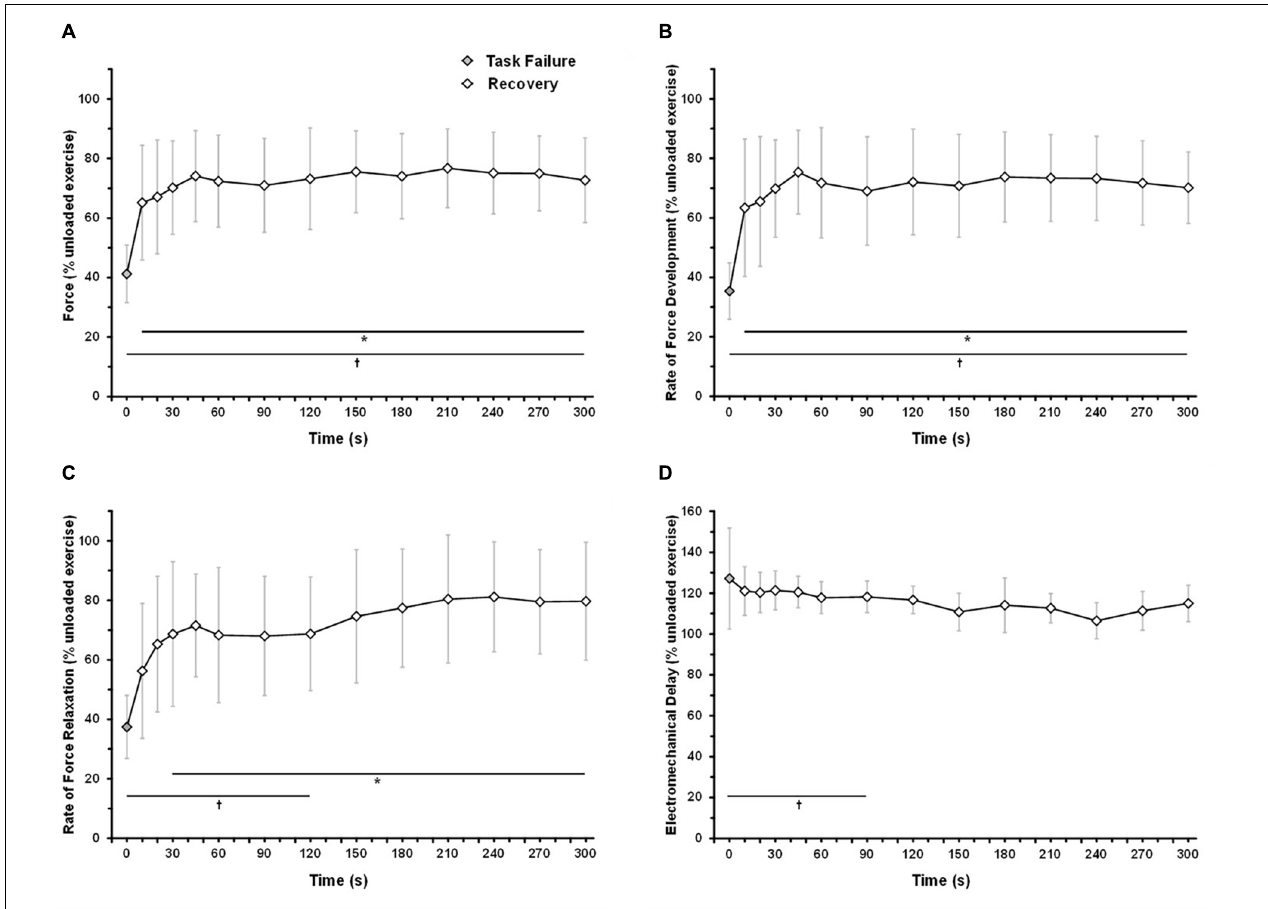
FIGURE 4 | Time-course of force and intratwitch indices recovery following an exhaustive 6-min exercise. The subjects performed one-legged knee-extension exercise at 6MP until exhaustion. At task failure, the load was removed, and the subjects were instructed to maintain the kicking frequency at 60 rpm (unloaded exercise). Force response from VL was elicited by an electrical stimulation (double twitch, 10-ms interval) 10, 20, 30, 45, and 60 s after task failure and subsequently every 30 s until 5-min recovery. (A) Force response, (B) rate of force development, (C) rate of force relaxation, (D) electromechanical delay. The data are mean ± SD. Holm–Sidak corrected post hoc test results. *CP+5% significantly different from task failure ( P < 0.05); † CP significantly different from unloaded exercise ( P <